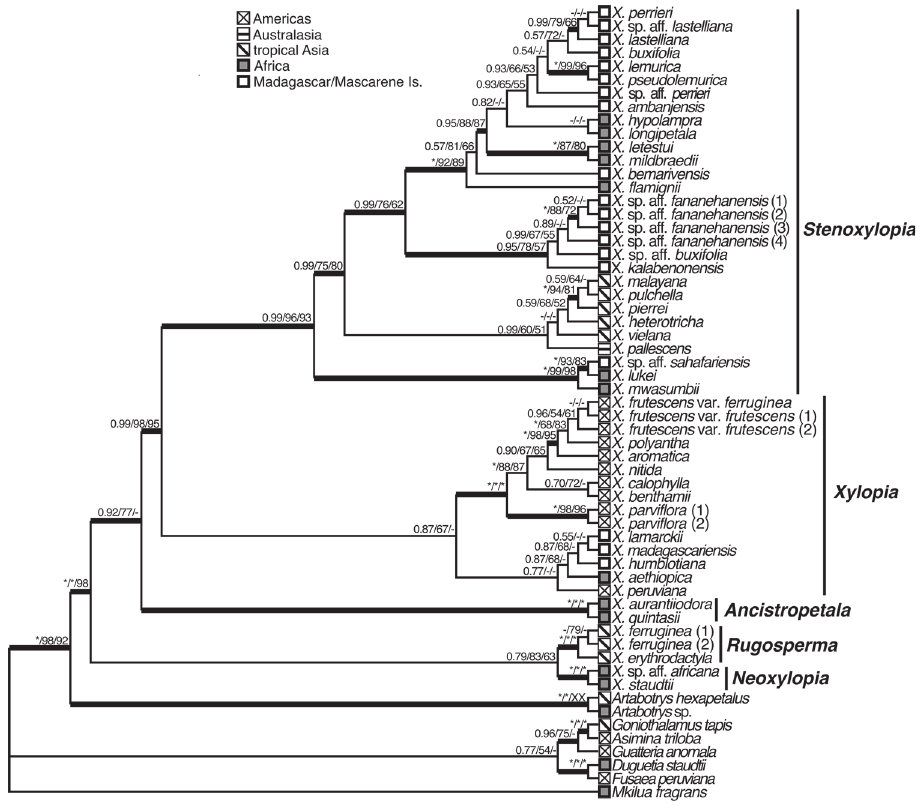
Figure 1. Maximum clade credibility tree for Xylopia . Tree obtained from Bayesian analysis of the four- marker data set for 44 Xylopia species, from Stull et al. (2017), showing geographic distribution, major clades, and relationship of named sections. Species of the first diverging subclade of the Stenoxylopia clade, X. mwasumbii , X. lukei , and X. sp. aff. sahafariensis , are placed in this revision into a new section, sect. Verdcourtia . Figure reproduced with permission of the American Society of Plant